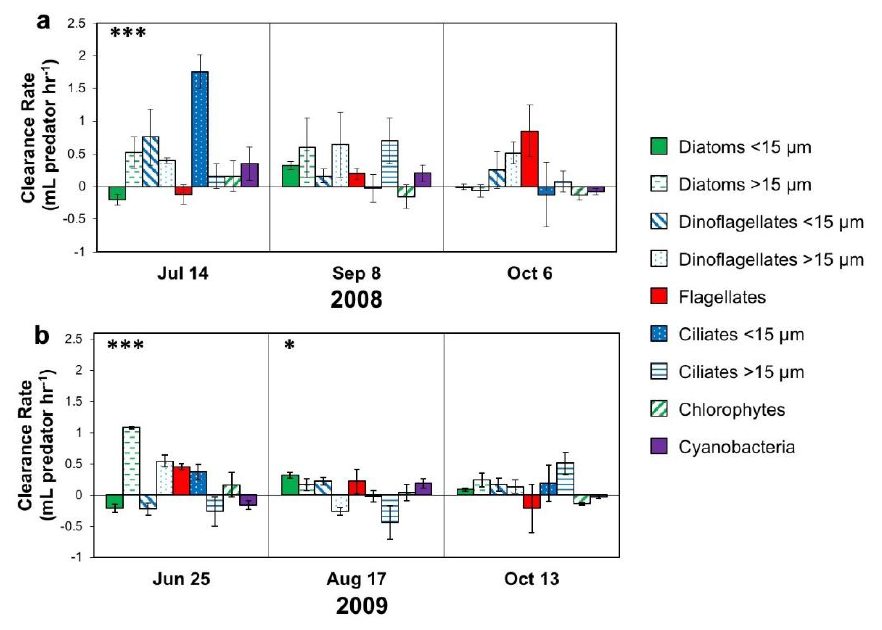
Figure 11. Clearance rates of Acanthocyclops robustus adult female copepods feeding on natural assemblages of plankton collected from Vancouver Lake before (June/July), during (August/September), and after (October) cyanobacterial blooms in ( a ) 2008 and ( b ) 2009. Error bars represent one standard error. ANOVA results: * = p < 0.05; *** = p < 0.001. Data from